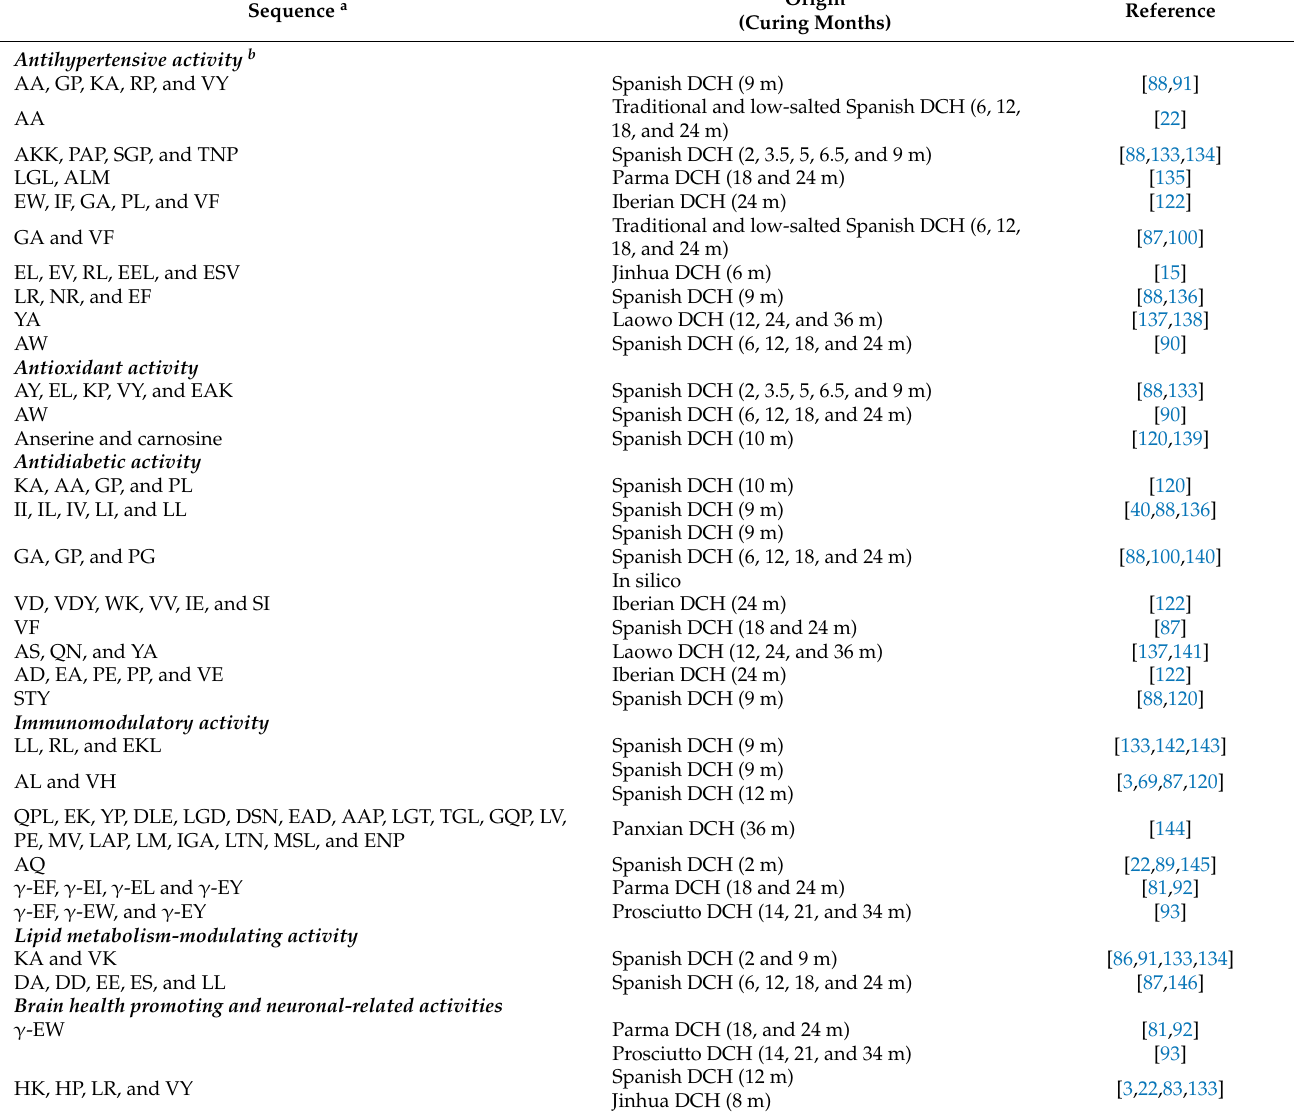
Table 3 congregates bioactive di- and tripeptides identified to date in dry-cured ham. Table 3. Dry-cured ham (DCH)-derived di- and tripeptides’ bioactivities. Sequence